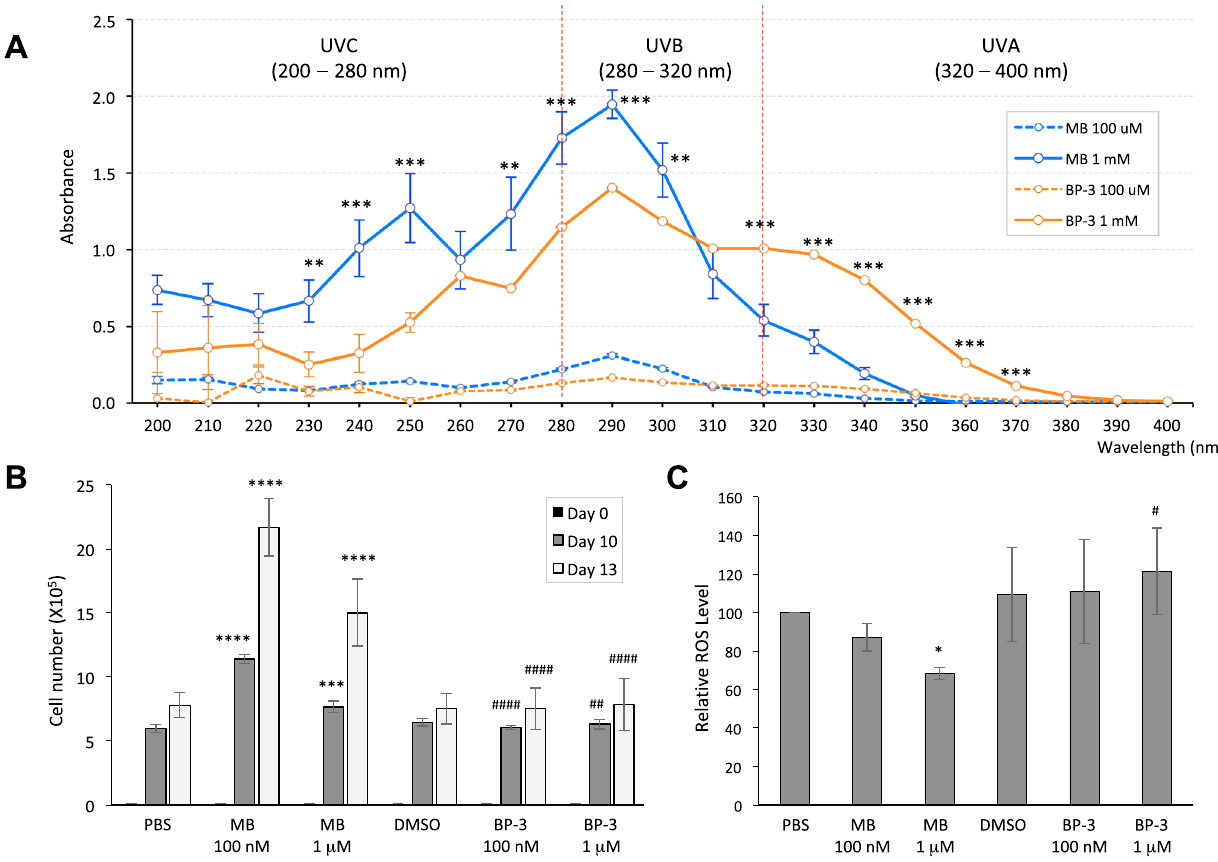
Figure 3. MB is a potent ROS scavenger with stronger UVB absorption than Oxybenzone (BP-3). ( A ) Graphs of UV absorption spectrum of MB and BP-3 at 100 μM and 1 mM. PBS, the solvent of MB, was used to establish blank reading for UV spectrum measurement. DMSO, the solvent of BP-3, at a final concentration of 0.01% in PBS, was measured for adjustment of BP-3 absorbance. (** p < 0.01, *** p < 0.001 MB 1 mM vs. BP-3 1 mM). ( B ) Keratinocytes were seeded at the same cell number on day 0 and maintained in culture medium containing PBS, 100 nM or 1 µM MB, 0.01% DMSO (solvent for BP-3), 100 nM or 1 µM BP-3, respectively. Cell counting was conducted on day 10 and day 13 to compare the cell proliferation under different treatments. *** p < 0.001; **** p < 0.0001 comparing with PBS on the same day ; ## p < 0.01 #### p < 0.0001 MB versus BP-3 on the same day and same concentration. ( C ) Keratinocytes pretreated with PBS, 100 nM MB, 1 µM MB, 0.01% DMSO, 100 nM BP-3 and 1 µM BP-3 for 2 weeks were examined for mitochondrial specific superoxide (MitoSOX) levels by FACS on day 14. * p < 0.05 comparing with PBS; # p < 0.05 MB 1 µM versus BP-3 1